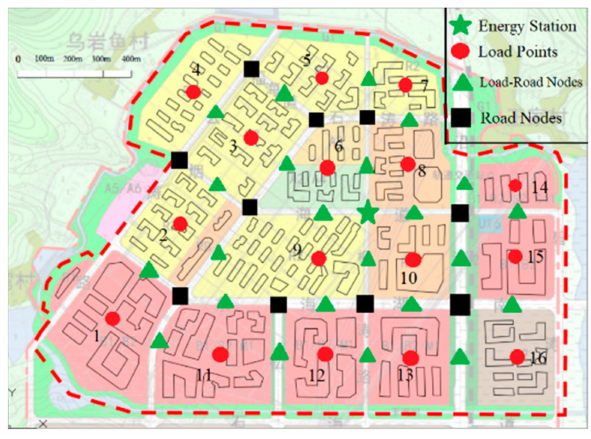
Figure 3. Preprocessing of the study